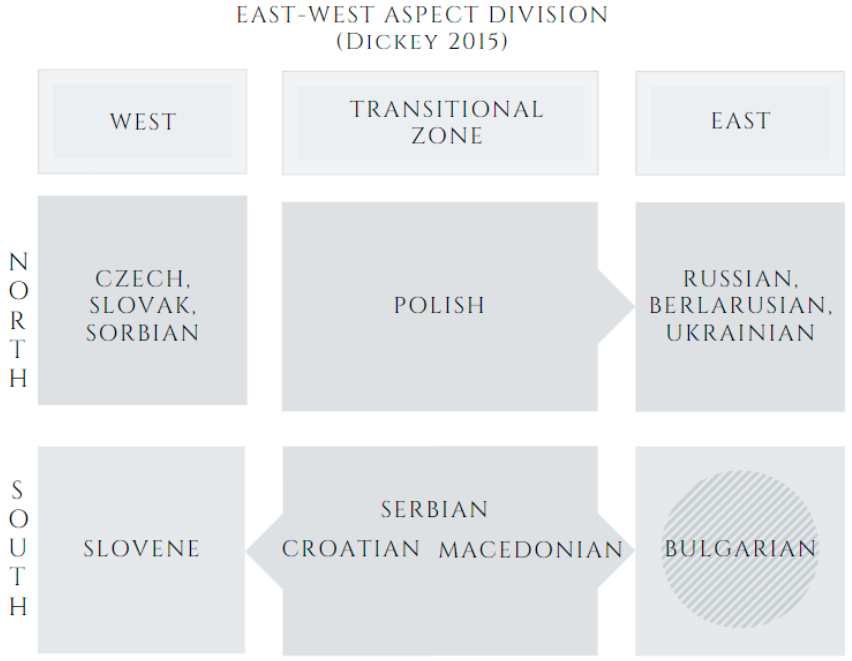
Figure 2. The East–West aspect division according to Dickey (2015) .